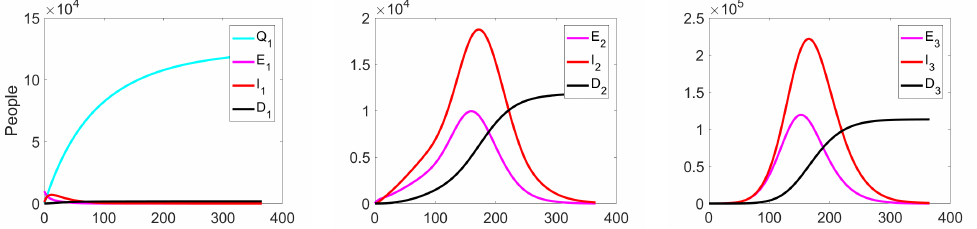
Figure 11. Experiment 2. Number of Exposed, Infected, and Dead in controlled